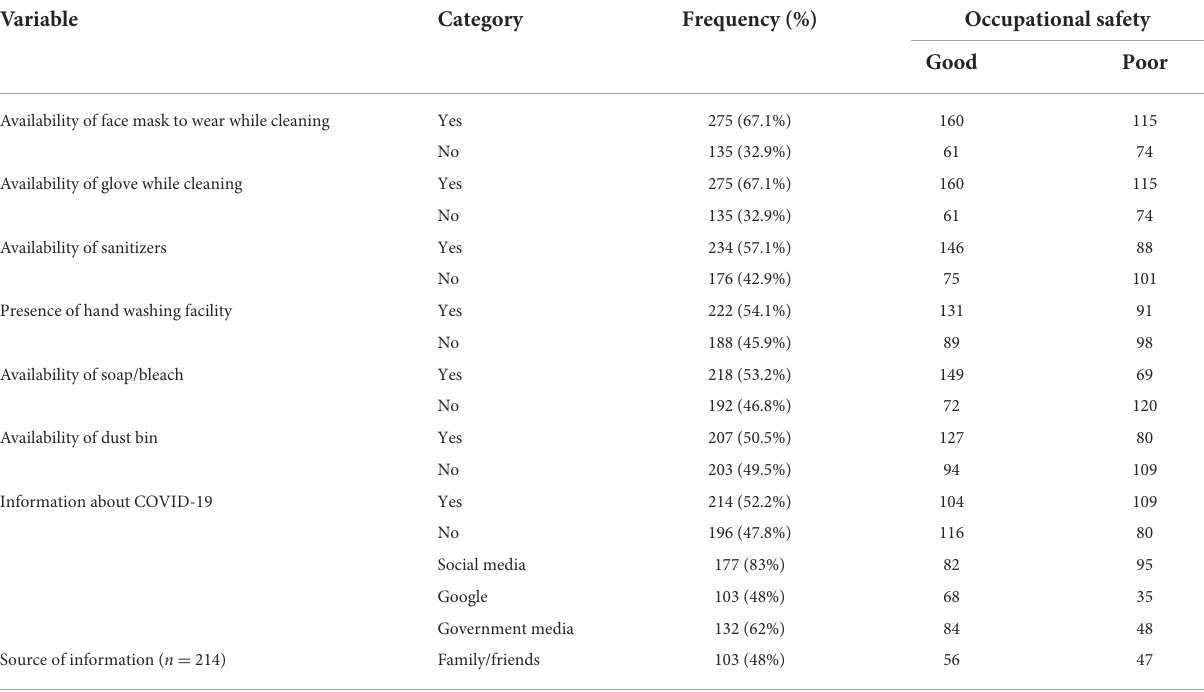
TABLE 2 Availability of personal protective equipment to prevent COVID-19 transmission among the janitors of the Bule Hora University, Southern Ethiopia from November to December